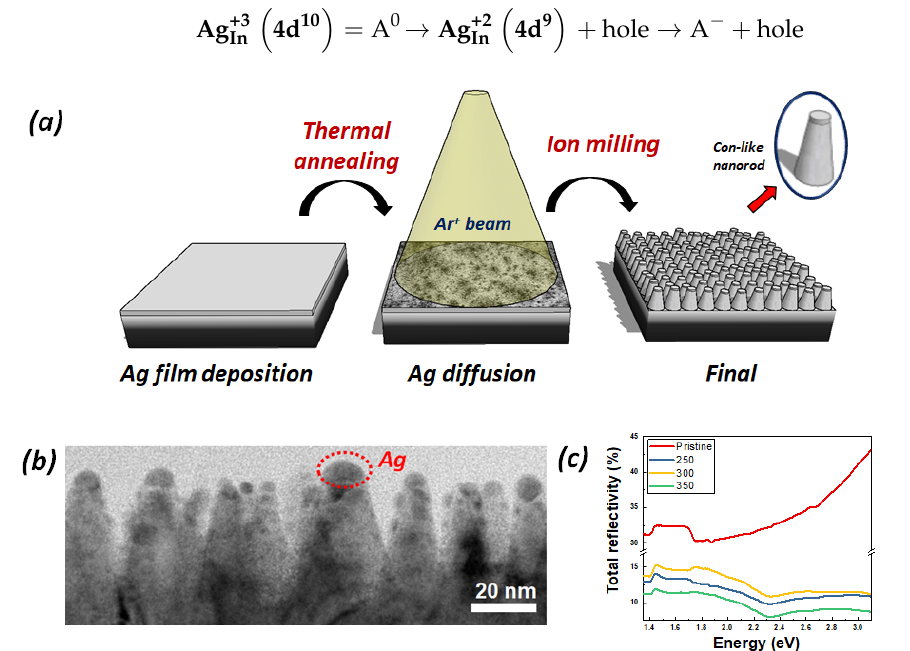
Figure 1. ( a ) Schematics illustration of the InZnP:Ag nano-rod fabrication process. ( b ) The cross-sectional TEM image of InZnP:Ag nano-rods after 20nm ion milling. ( c ) The total reflectivity of InP:Zn(pristine) and InZnP:Ag nano-rods annealed at 250, 300, and 350 ◦ C.